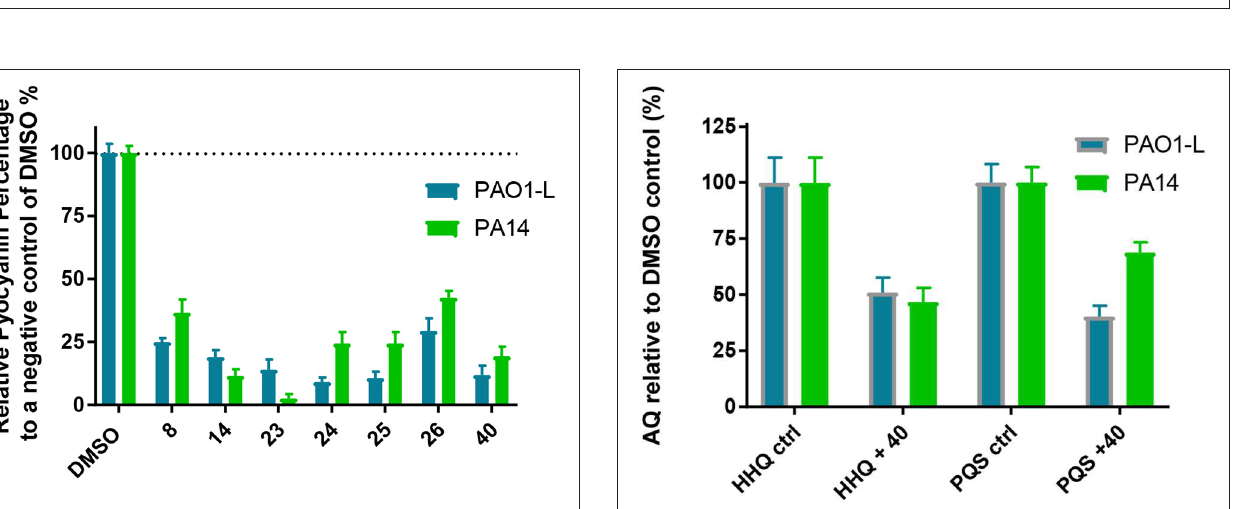
FIGURE 5 | Effect of compound 40 on AQ production: Quantification of AQ concentrations after treatment with the PqsR inhibitor 40 at 3x IC 50 value for PAO1-L and PA14 each strain. The graph represents the average of three independent experiments carried out in triplicate ( n = 9 ) for both